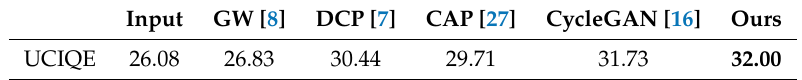
Table 1. Underwater image enhancement evaluation based on UCIQE [22] metric. Larger metric means better